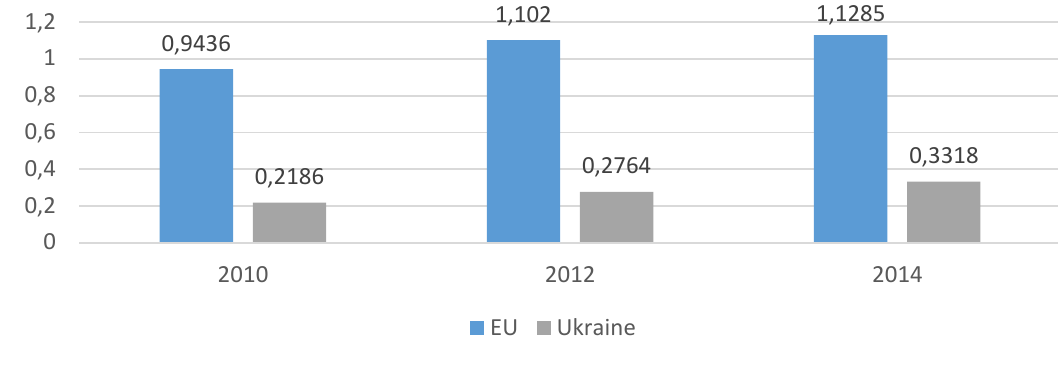
Figure 2. The Innovation Indexes of light industry of Ukraine and the EU countries